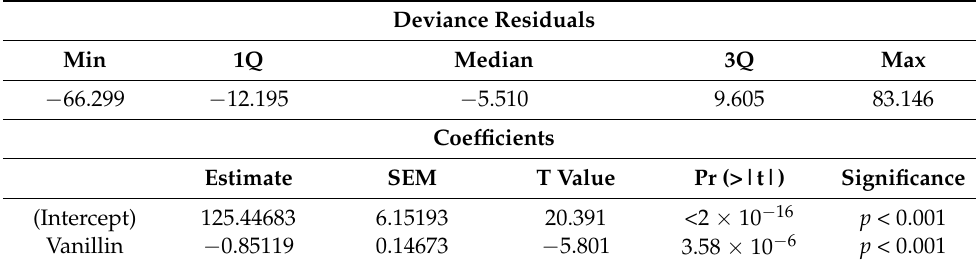
Table 3. GLM 2 Summary (antioxidant capacity, FRAP).